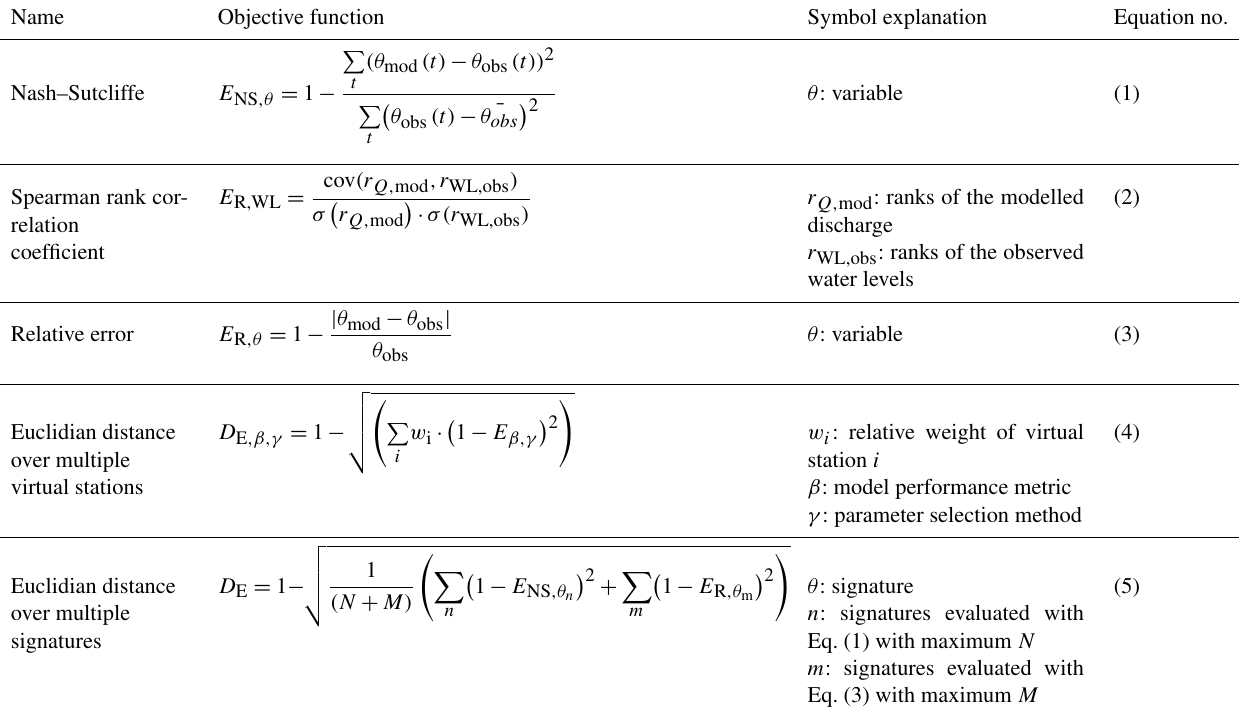
Table 4. Equations used to calculate the model